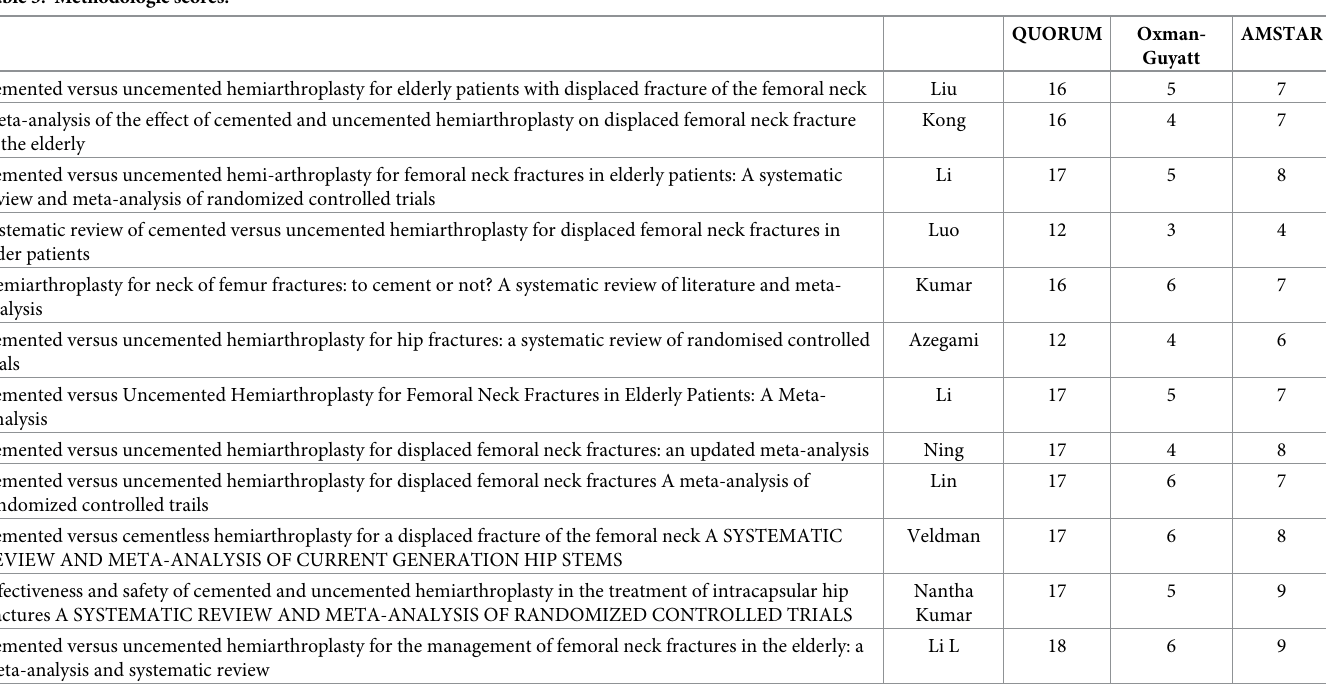
Table 5. Methodologic